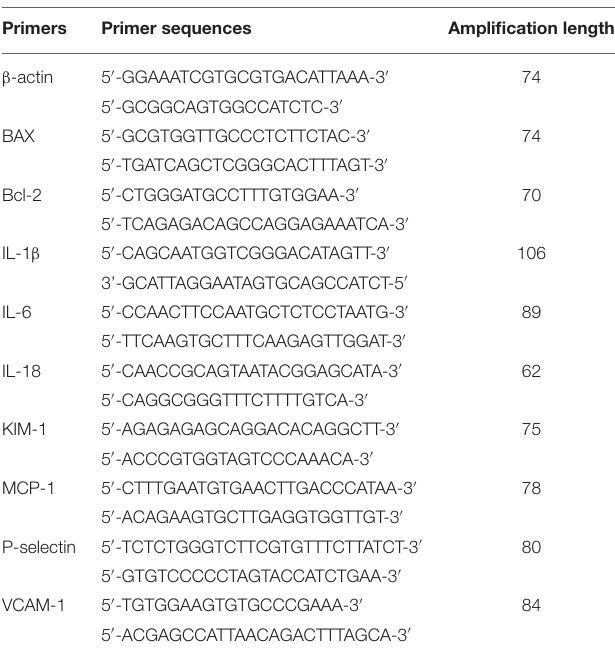
TABLE 3 | Gene-specific qPCR